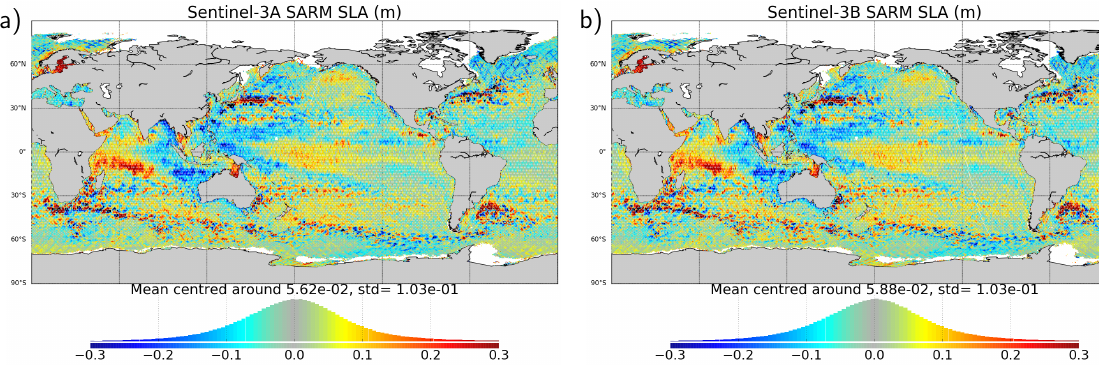
Figure 28. Maps of Ku-band Sea Level Anomaly computed using radiometer Wet Tropospheric Correction over Sentinel-3B cycle 35 (i.e., from 25/01/2020 to 21/02/2020), for Sentinel-3A ( a ) and Sentinel-3B ( b ).